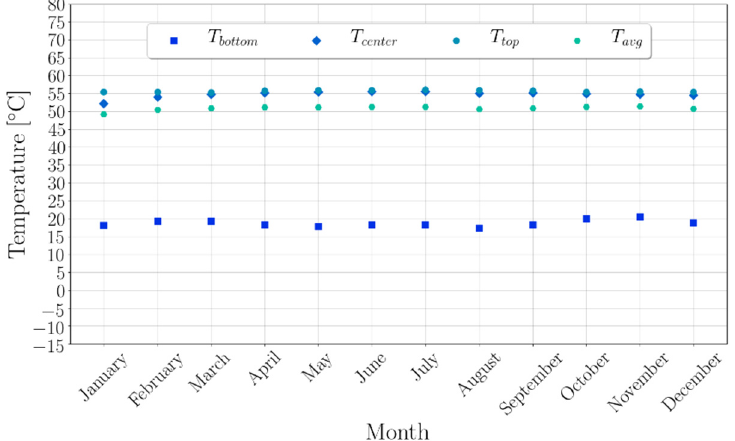
Figure 18. Monthly mean fluid temperature at distinct locations inside the domestic hot water storage tank.